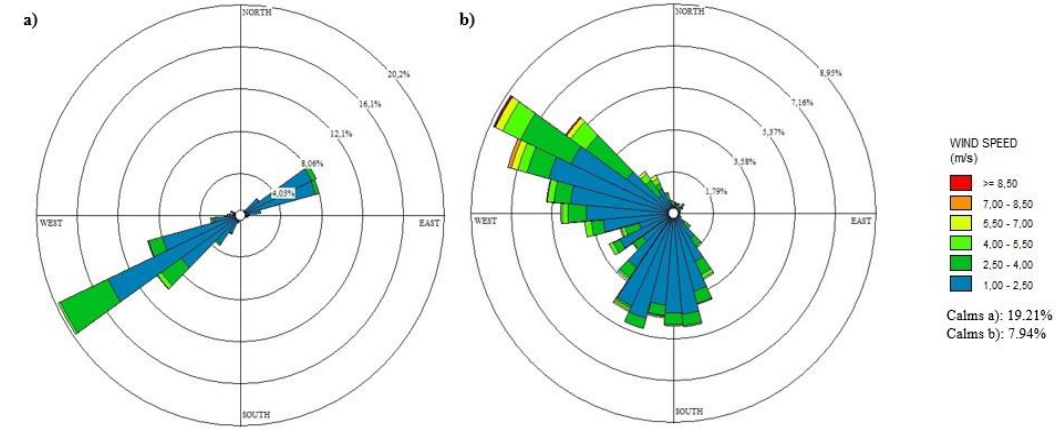
Figure 2. Wind rose during the study period (2015–2019) for ( a ) Cordoba city and ( b ) the Valdejetas Figure2. Windroseduringthestudyperiod(2015–2019)for( a )Cordobacityand( b estate.